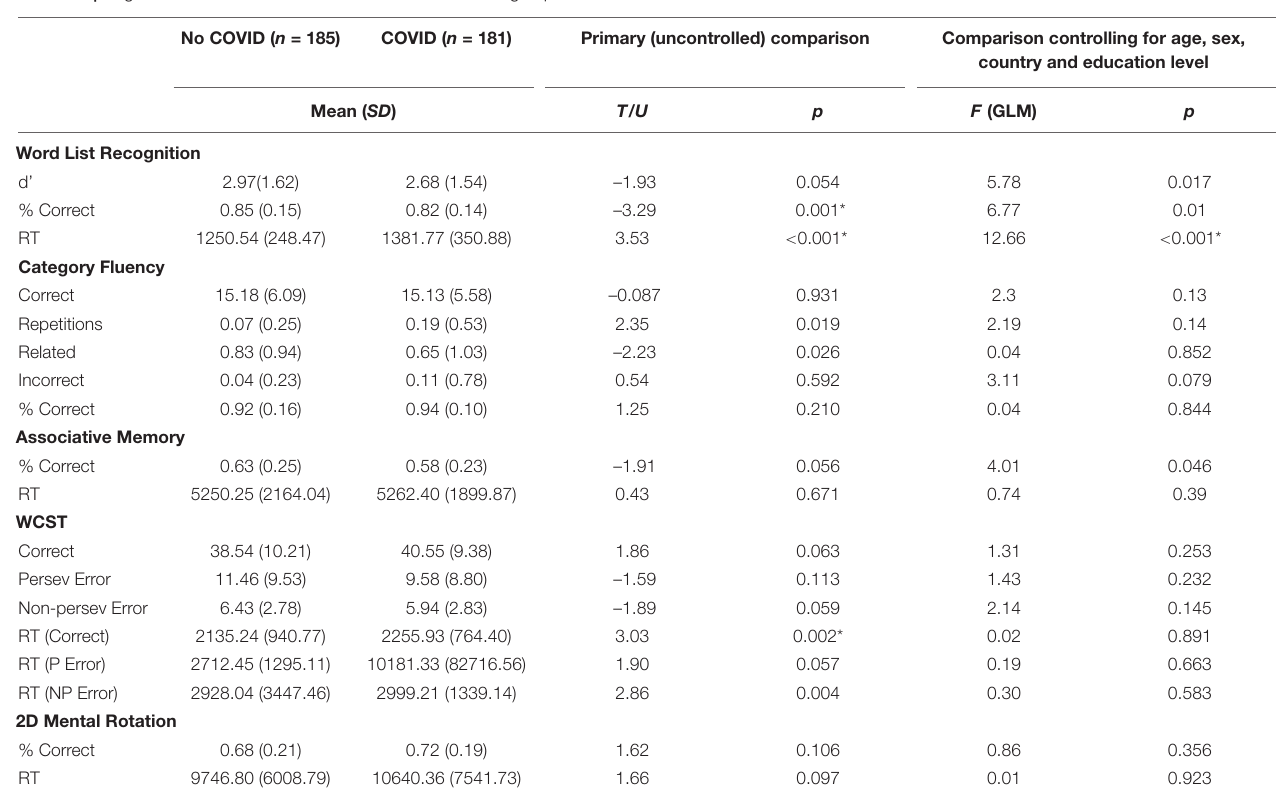
TABLE 2 | Cognitive task results between No COVID and COVID groups. COVID ( n = 181) Primary (uncontrolled) comparison Comparison controlling for age, sex,